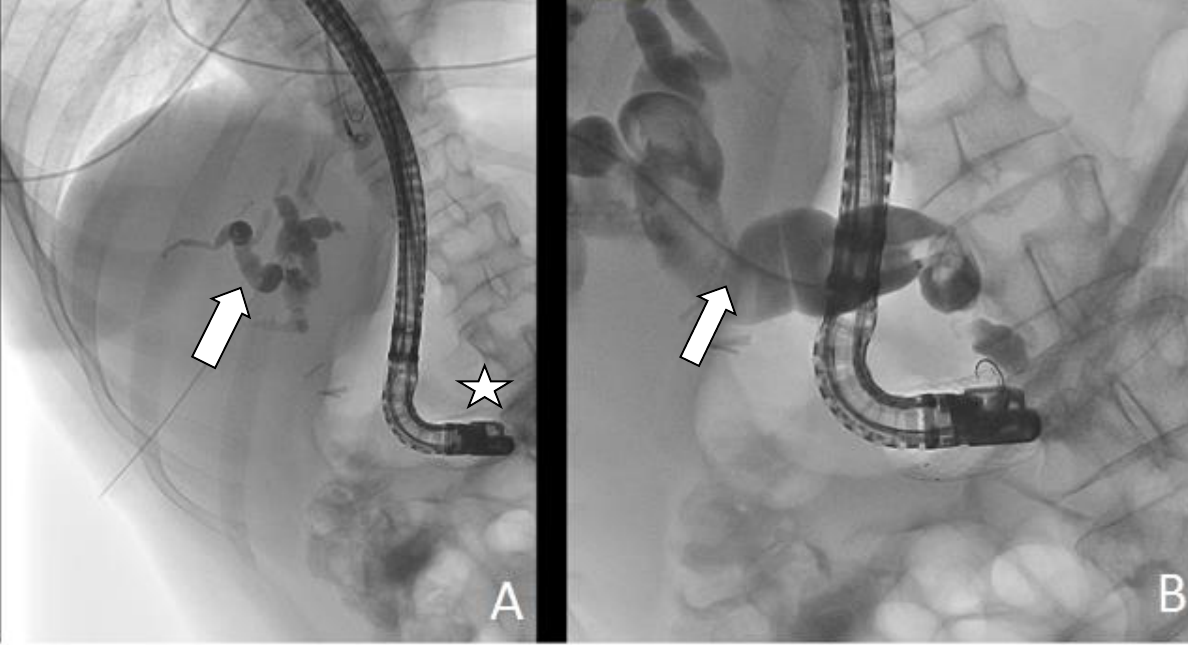
Figure 5. PTC. ( A ) On the left, the image shows the execution of a PTC (percutaneous transhepatic cholangiography) showing some biliary branches (arrow), while the sphincterotome is stationary at the level of major papilla (star). ( B ) On the right, the catheter (arrow) was inserted through percutaneous access and reached the major papilla .